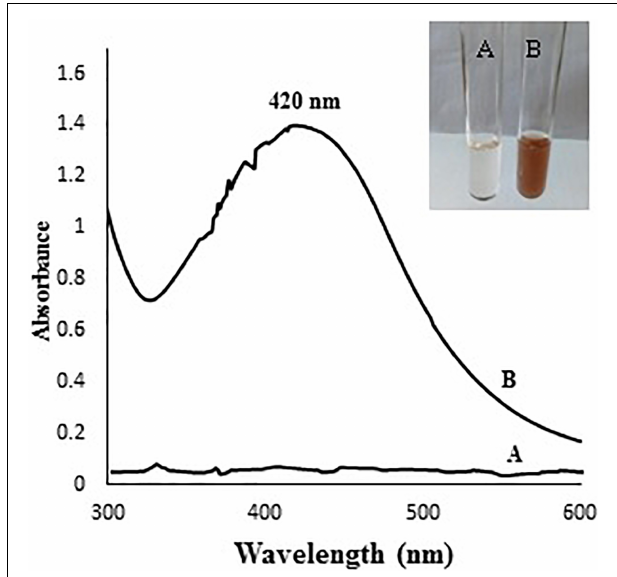
FIGURE 1 | (A) colorless mycelial filtrate, (B) brown color due to AgNPs formation. The chart shows UV-Visible absorption spectrum of A. terreus BA6 AgNPs after 72